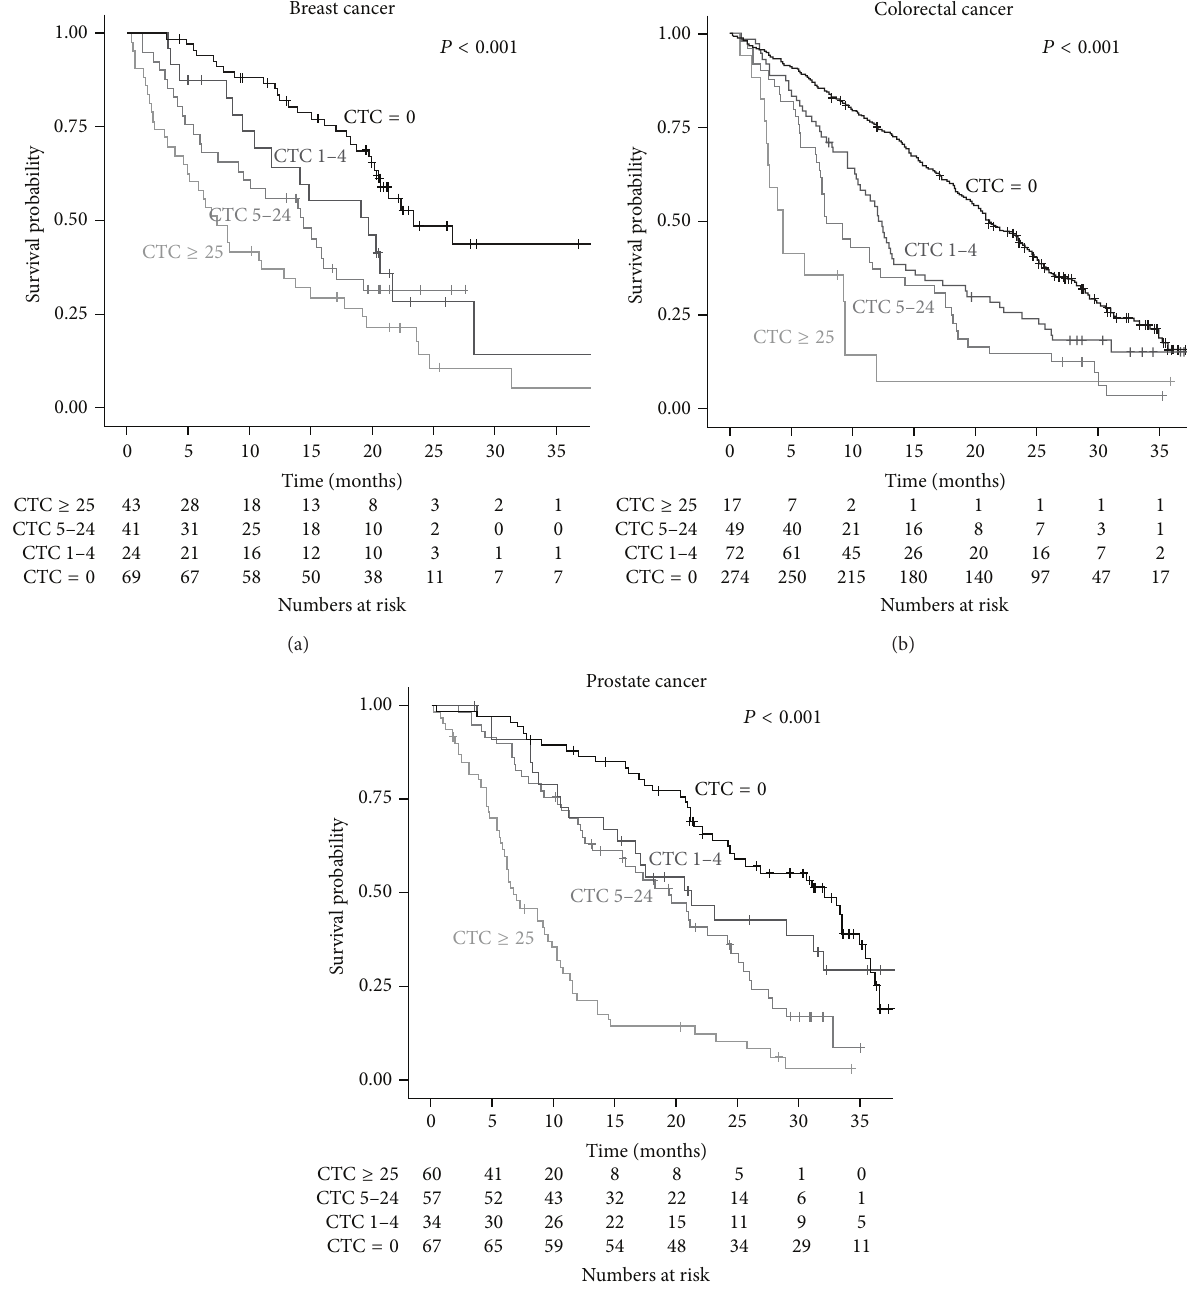
qualification, increase the frequency of objects counted as CTC in patients and controls [46]. EpCAM+ CK+ CTC can be differentiated into intact CTC, CTC fragments, and CTC microparticles. The presence of all these is associated with a relatively short survival in castrate resistant prostate cancer [36]. However, intact CTC containing DNA can provide more information, as they are receptive to molecular and